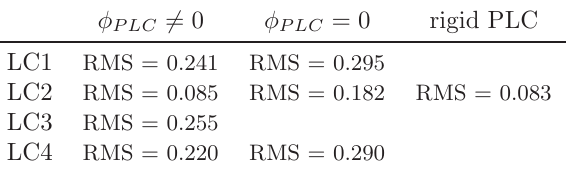
Table 5: Conducted